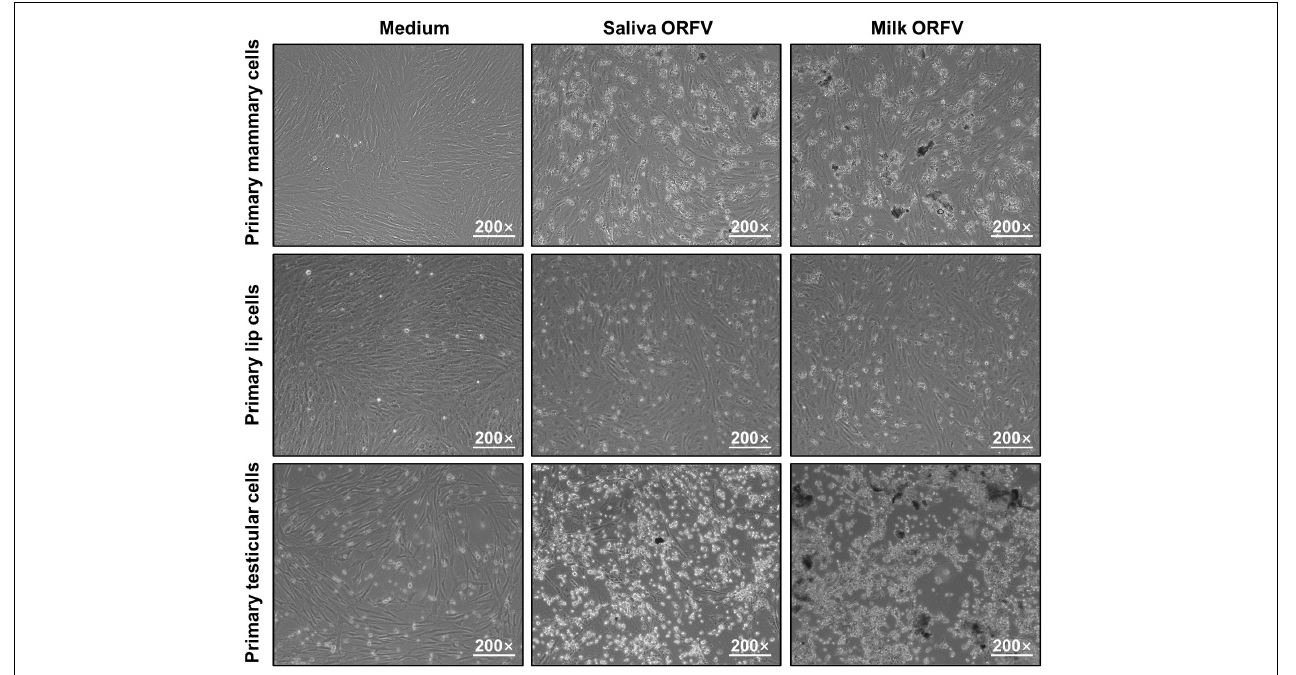
FIGURE 2 | Infection of permissive cells by ORFV isolated from the saliva and milk of dairy goats. Goat Primary lip cells, mammary cells and testicular cells were cultured and infected with ORFV (10 5 . 6 /1 mL TCID50) isolated from the saliva or milk of dairy goats. Control cells were treated with MEM of the same volume. 72 h later, the cells were observed under a light